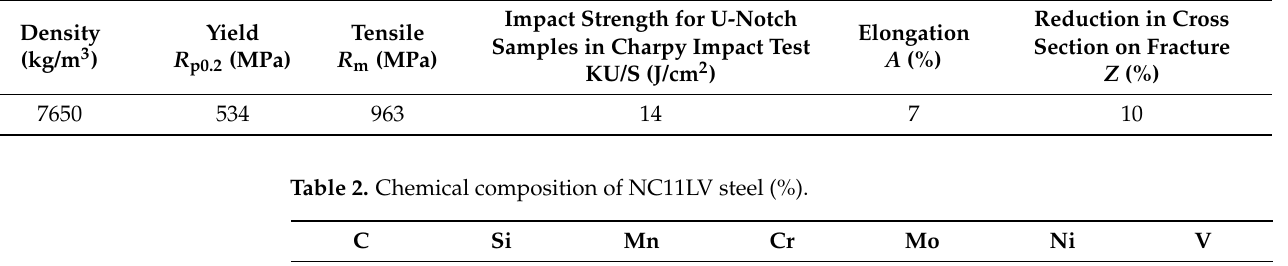
Figure 3. The geometry of nibbling equipment. Table 1. Mechanical properties of NC11LV steel.